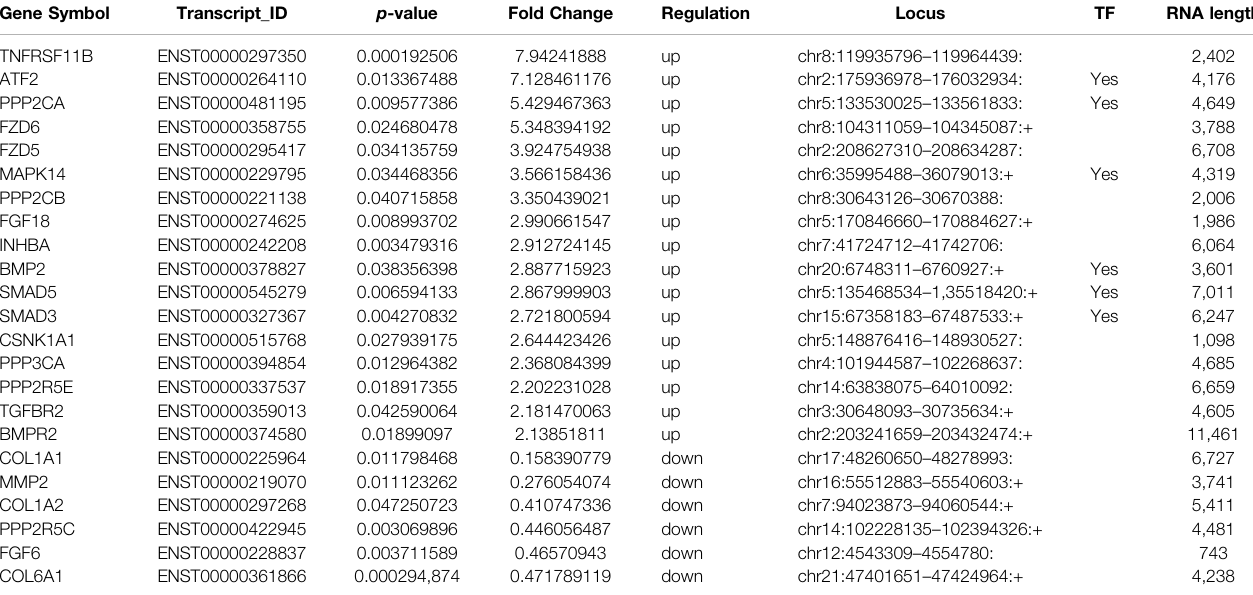
TABLE 2 | The detailed information of DE